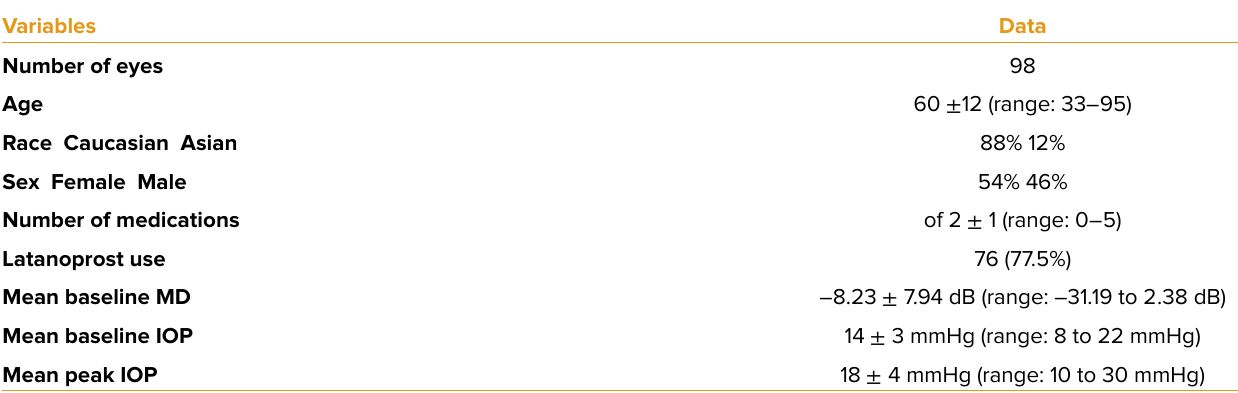
Table 1. Baseline characteristics Variables Data